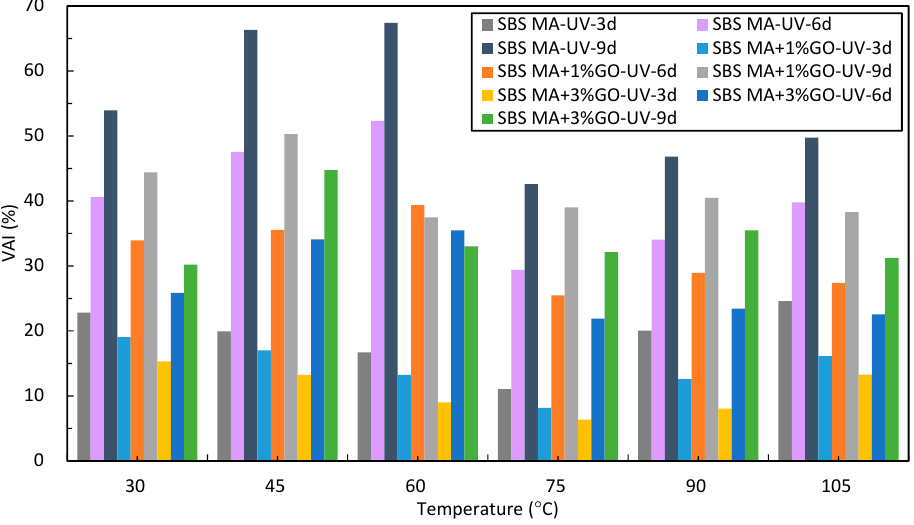
Figure 8. VAI of SBS MA and GO modified SBS MA after UV aging.